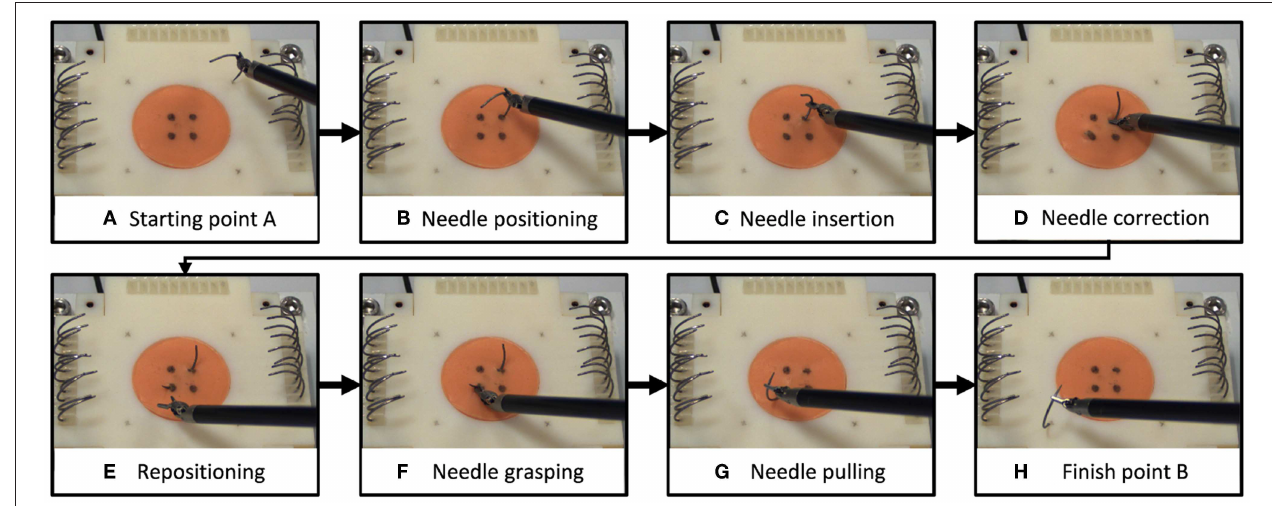
FIGURE 1 | Needle driving task. We divided the needle driving task into 8 subtasks (A–H) . On each trial, participants (A) grasped a needle and positioned it above the starting point, (B) transported the needle to the insertion point and positioned it, and (C) inserted the needle into the tissue (1st insertion). (D) If needed, participants repositioned the tool on the needle and continued in insertion (2nd insertion). Then they (E) repositioned the tool on the needle for extraction, (F) grasped the needle for extraction, (G) extracted the needle, and (H) positioned the needle above the finish